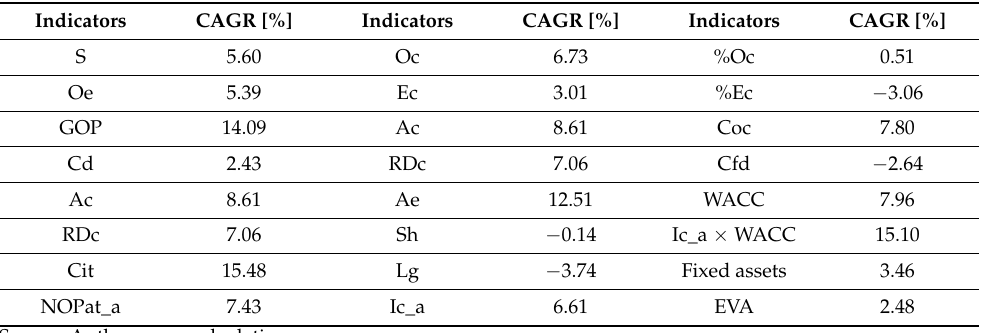
Table 7. Compound Annual Growth Rate.